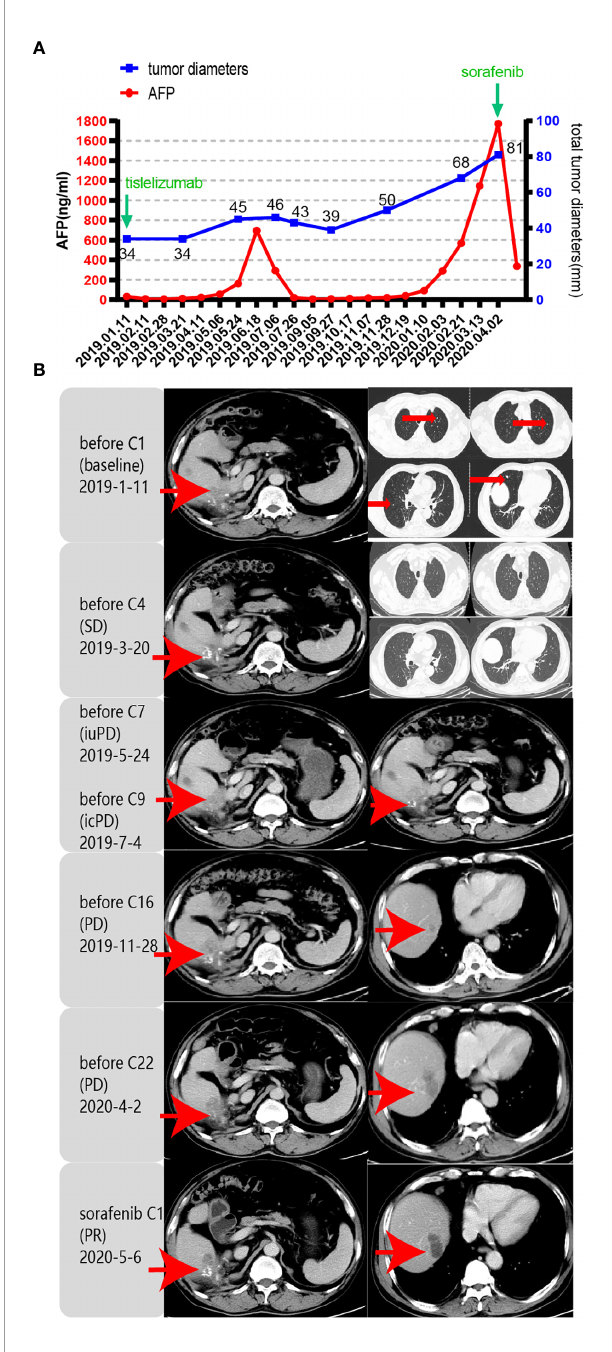
FIGURE 1 | Response evaluation during the clinical course including changes in imaging and quantitative data. iuPD (immunity uncon fi rmed progressive disease); icPD (immunity con fi rmed progressive disease). (A) Trends in the levels of tumor monitoring indicators, including AFP (left Y-axis) and tumor diameters (right Y-axis) corresponding to the treatment timeline. X-axis showing the date of the disease course. The frequency of imaging evaluations is less than that of AFP. (B) Representative images of the CT scan revealed the increasing and decreasing process of both primary and metastatic lesions in the liver and lung after PD-1 antibody (tislelizumab) and sorafenib treatment. Red arrows indicate tumor